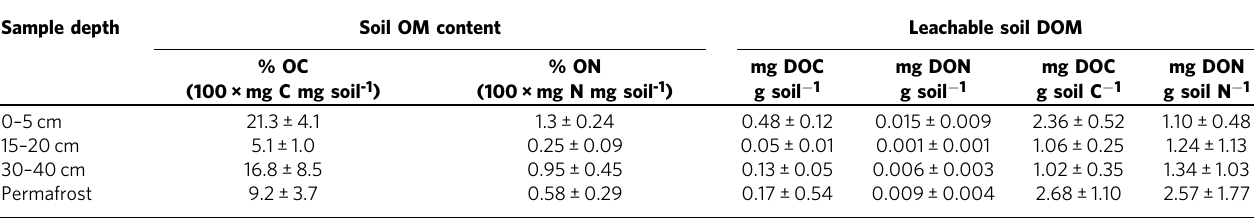
The permafrost category represents soils at approximately 5 – 10cm below the ice table. Values are ±1 standard error, n = 3 for all samples.